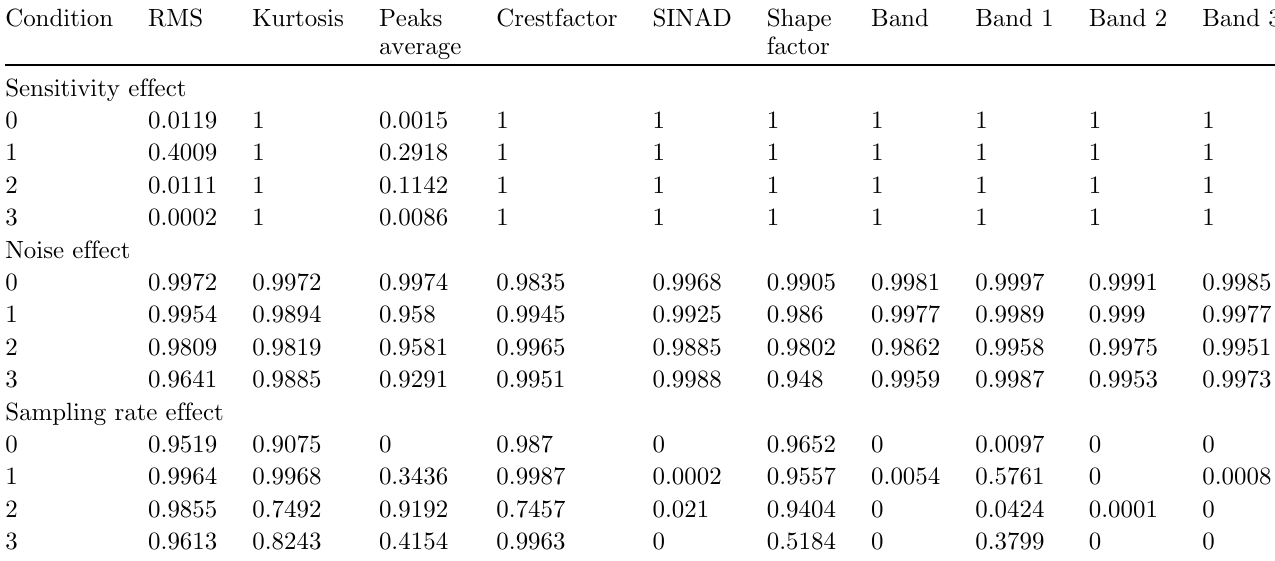
Table 1. ANOVA test for the test case 1: p -values.